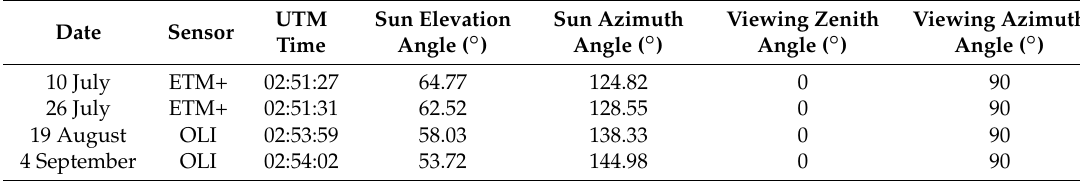
Table 2. The parameters of the Landsat 7 and 8